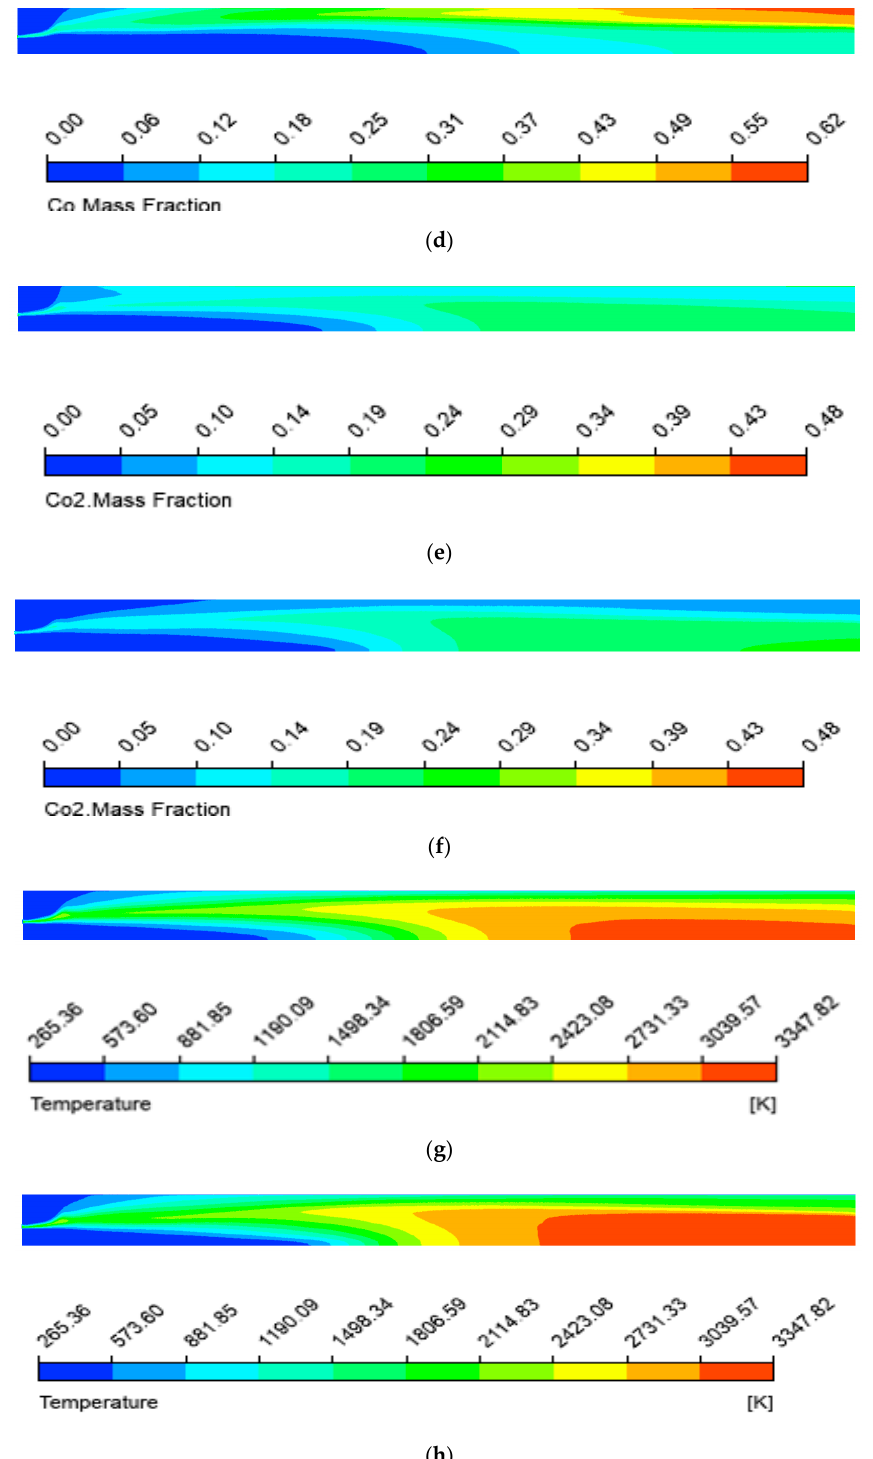
Figure 11. ( a ) H 2 O distributions given by the RAMEC mechanism, ½ axial scaling; ( b ) H 2 O distributions given by the Zhukov–Kong mechanism, ½ axial scaling; ( c ) CO distributions given by the RAMEC mechanism, 1 axial scaling; ( d ) CO distributions given by the Zhukov–Kong mechanism, 1 2 2 axial scaling; ( e ) CO 2 distributions given by the RAMEC mechanism, 1 axial scaling; ( f ) CO 2 distribu- 2 tions given by the Zhukov–Kong mechanism, 1 axial scaling; ( g ) Temperature distributions given by 2 the RAMEC mechanism, 1 axial scaling; ( h ) Temperature distributions given by the Zhukov–Kong 2 mechanism, 1 axial 2